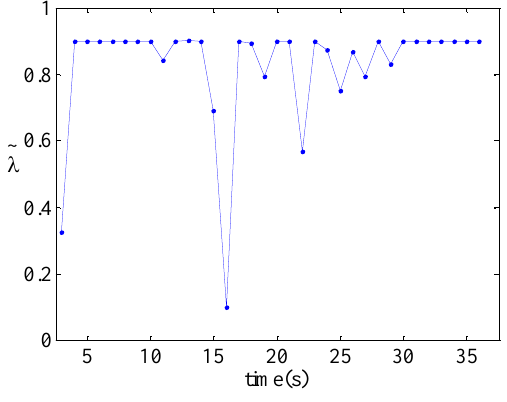
~ λ for target II.